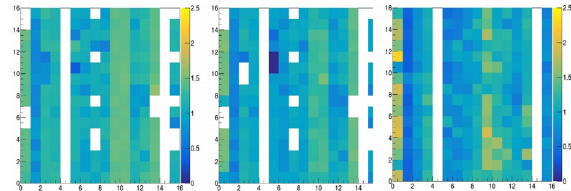
Figure 2. Left: Instant track-like flashes’ waveforms of ten Figure 4. Calibration of PMTs and comparison to pre-flight mea- PMTs with the highest amplitudes. Right: the waveforms of surements. Relative PMT gain calibration was done by analyz- slow-flashes Figure 3. The EAS candidates. Upper plots – image of event ing background events and is presented here for 2 statistically with hit pixels and not-working (blue) ones. Bottom plots – the independent subsets of data (left and center). Pre-flight measure- amplitude variation of time for selected hit pixels. ments (right) are shown with 2 PMT modules that later stopped working turned o ff for